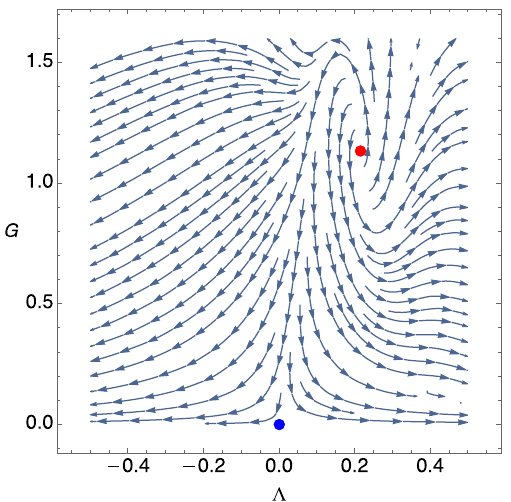
(cid:11) and G with the third coupling set to its UV fixed-point value σ (cid:16) . The red dot represents the non-Gaussian UV fixed-point and the blue dot the Gaussian IR fixed-point. The arrows flow towards the